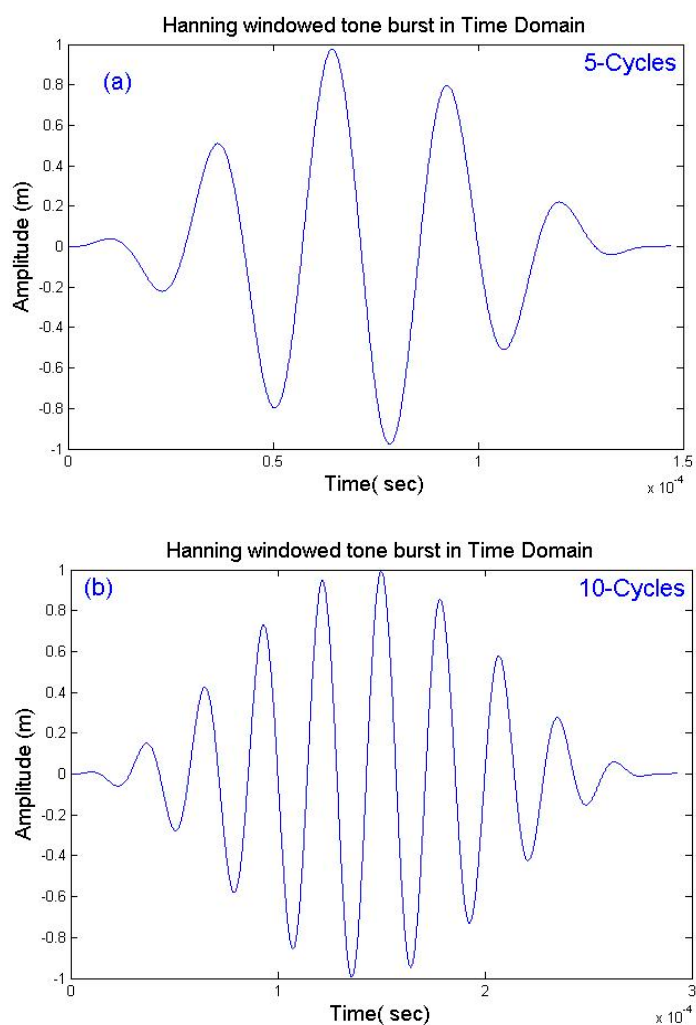
Figure 7. Hann-windowed tone burst at the frequency of 35 kHz: ( a ) 5 cycles and ( b ) 10 cycles.